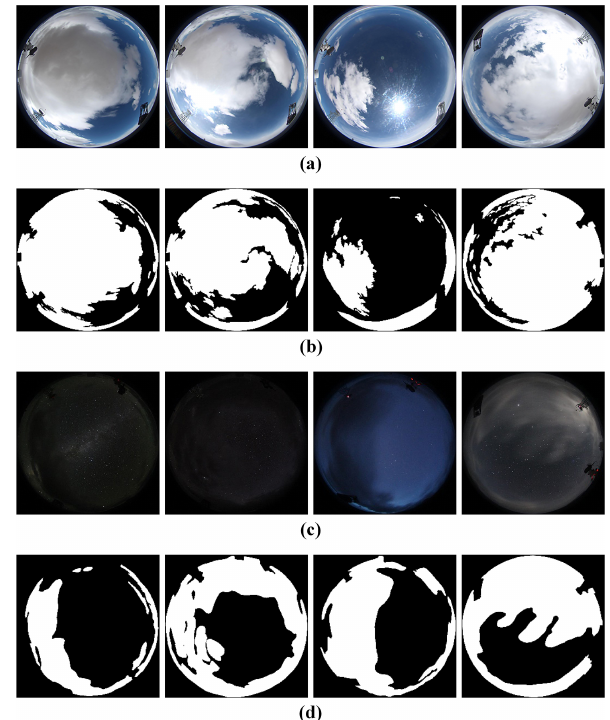
Figure 2. Diurnal and nocturnal original RGB color ASI images in the data set and the corresponding ground truth of the ASI images. (a) Diurnal original RGB color ASI images in the data set, (b) cor- responding ground truth ASI images from (a) , (c) nocturnal origi- nal RGB color ASI images in the data set, and (d) corresponding ground truth of ASI images from (c)